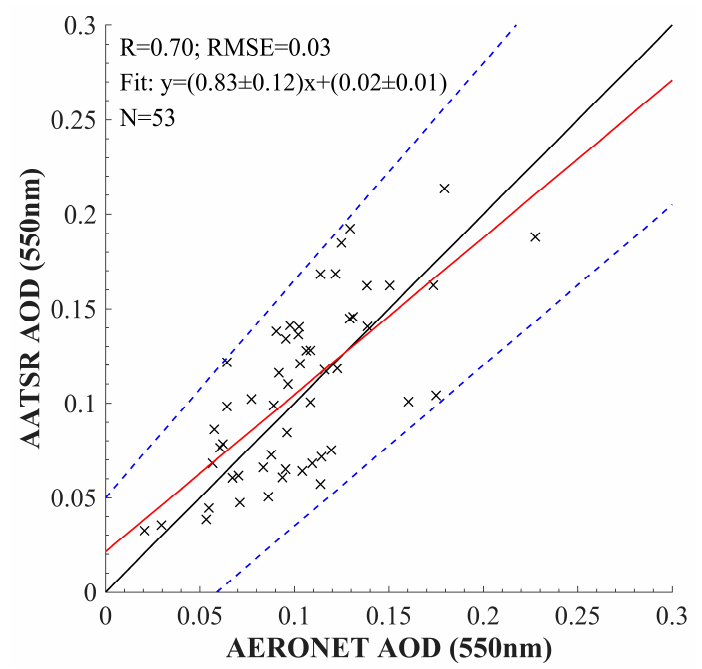
Figure 3. Validation of AATSR derived AOD at 550 nm compared to AERONET AOD.